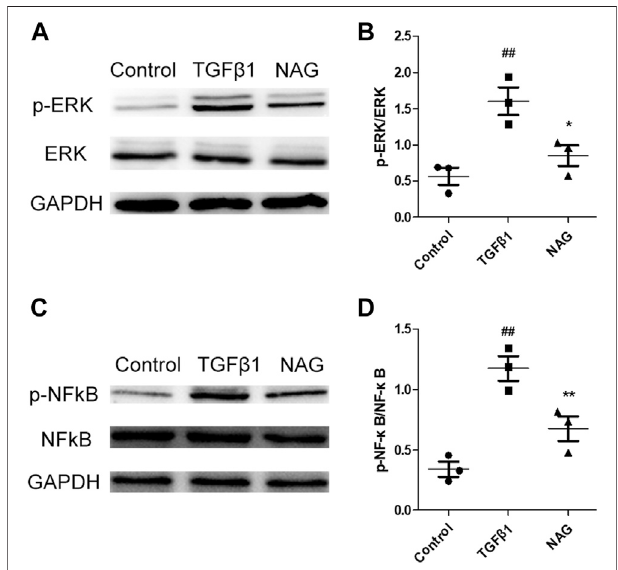
FIGURE 8 | Effects of naringin on ERK and NF- κ B signals. Serum- starved HUVECs were stimulated with TGF- β 1 (10 ng/ml) and the absence or presence ofnaringin (100 μ mol/L) for 48 h. Expressions of p -ERK, ERK (A,B) , p -NF κ B, and NF κ B (C,D) . ## p < 0.01 vs. control; * p < 0.05, ** p < 0.01 vs. MCT. n (cid:1)